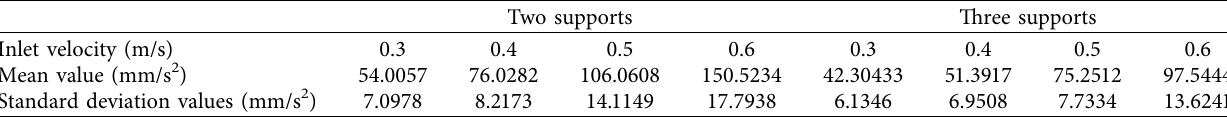
Figure 22: Diagram of the acceleration amplitude before and after optimization. (a) V � 0.3m/s. (b) V � 0.4m/s. (c) V � 0.5 m/s. (d) V � 0.6m/s. Table 4: Mean and standard deviation values.